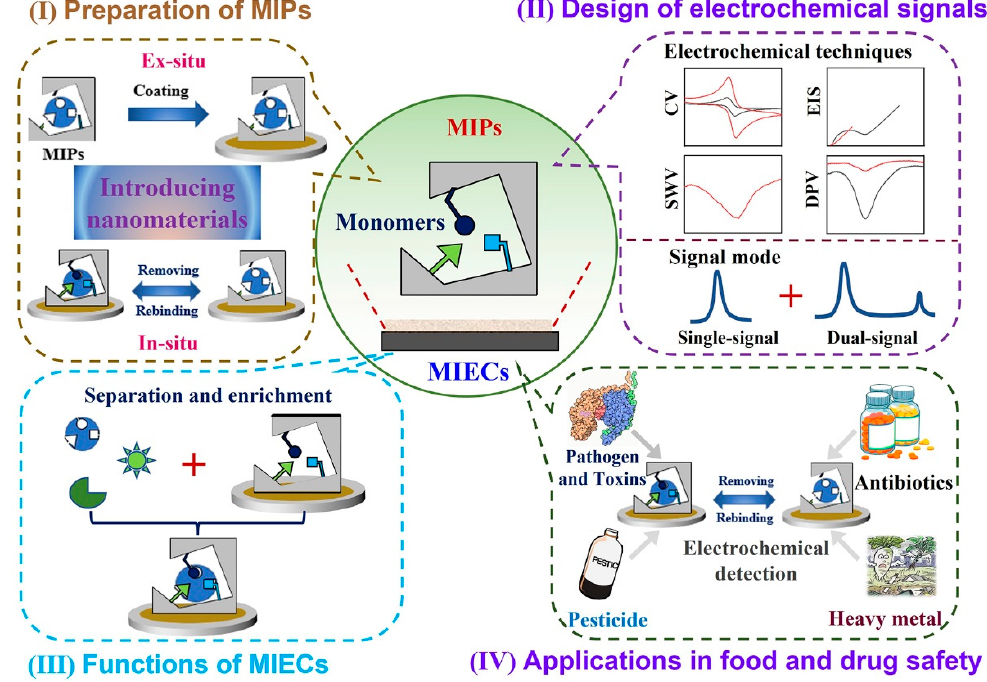
Figure 1. Schematic presentation of MIECs: (I) preparation of MIPs, (II) design of electrochemical signal, (III) functions of MIECs and (IV) applications in food and drug safety detection.